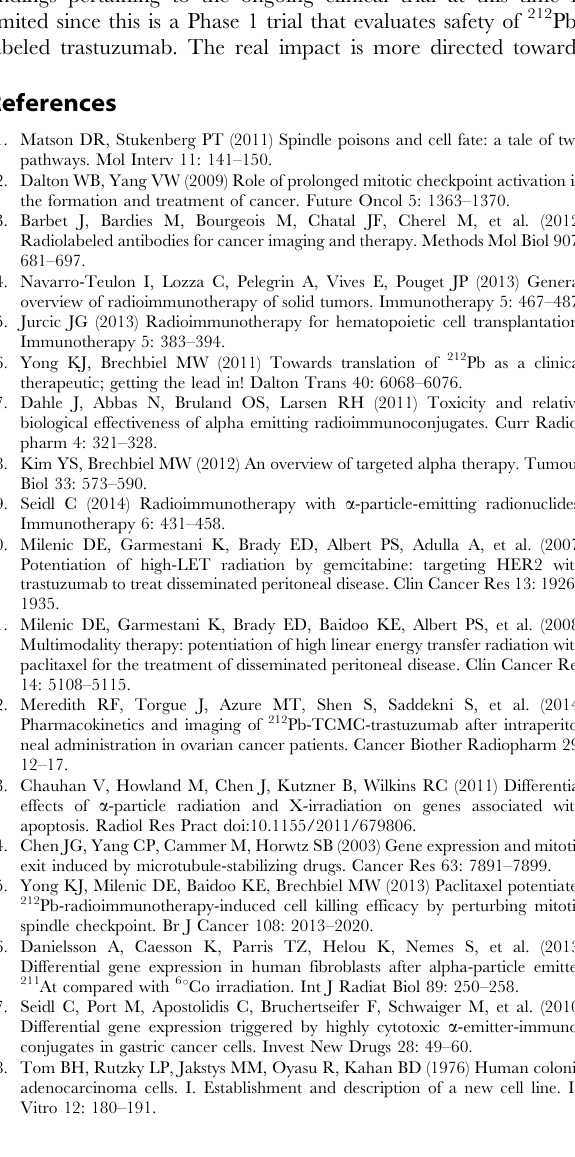
Table S1 Functional gene grouping. Comparison of the relative expression of 84 DNA damage related genes involved in apoptosis (Figure 1), cell cycle (Figure 2), and DNA damage repair (Figure 3) was characterized with the human DNA damage signaling pathway PCR